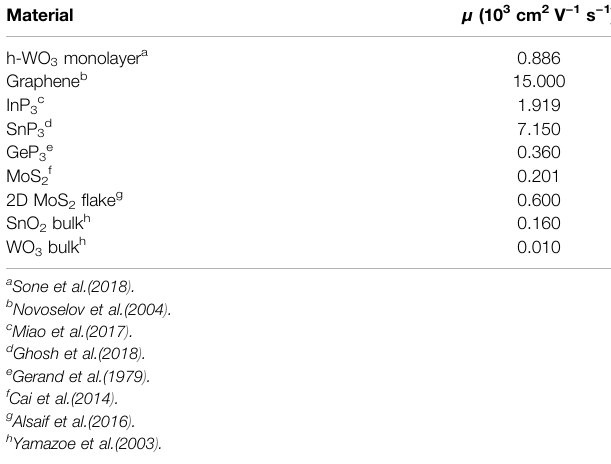
TABLE 2 | The carrier mobility μ at T (cid:2) 300